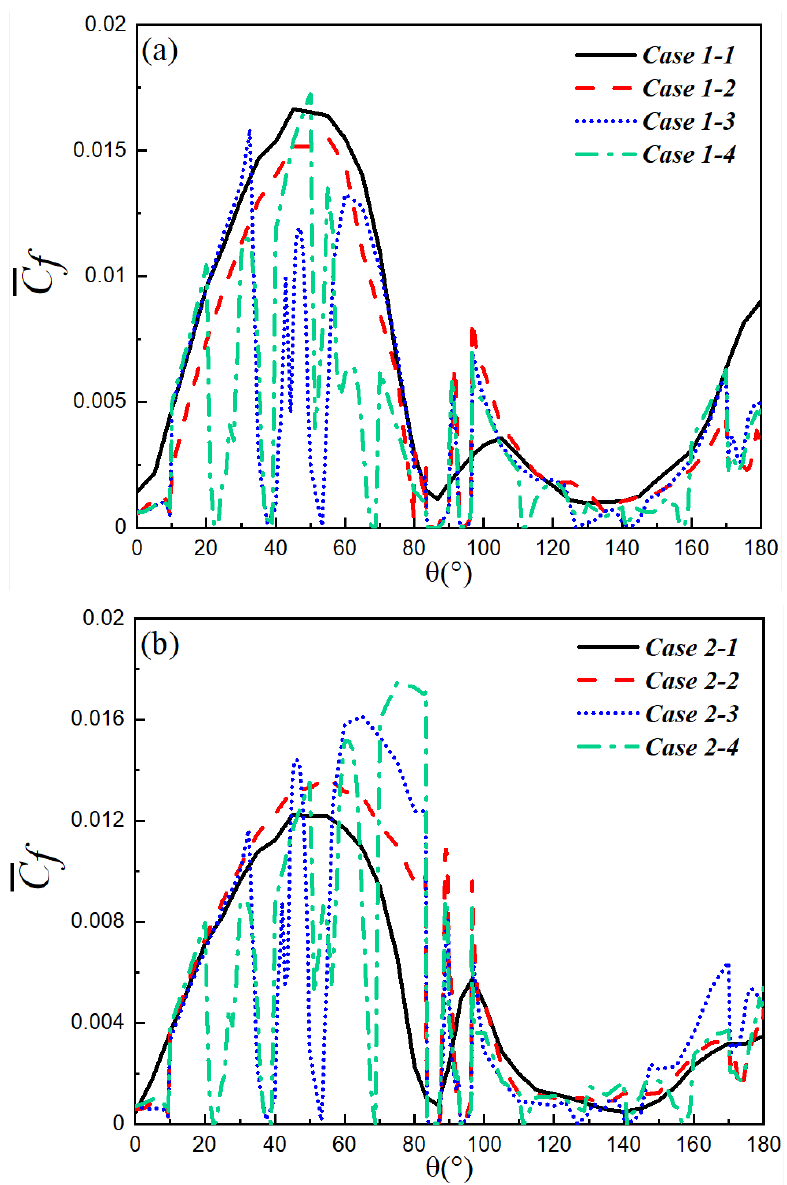
Figure 4. Distribution of time-averaged skin friction coefficient over the cylinder surface with different dimpled numbers: ( a ) Re = 1 × 10 5 ; ( b ) Re = 2 × 10 5 .